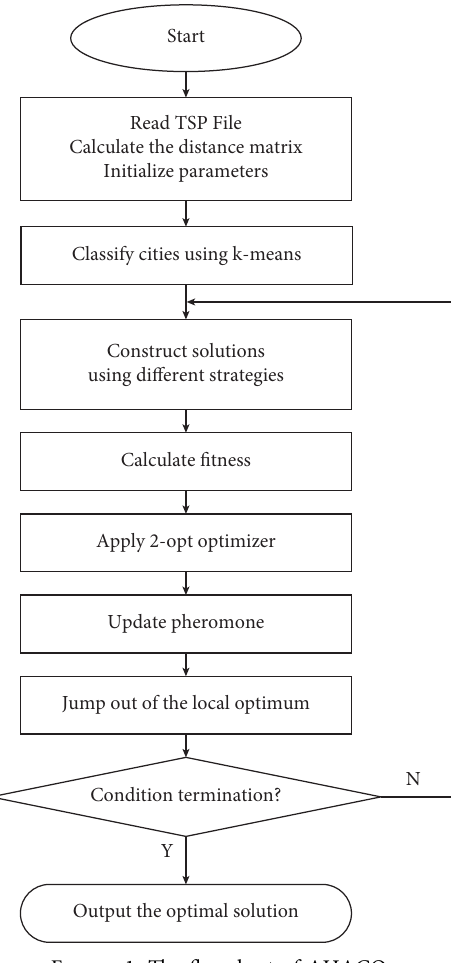
Figure 1: The flowchart of